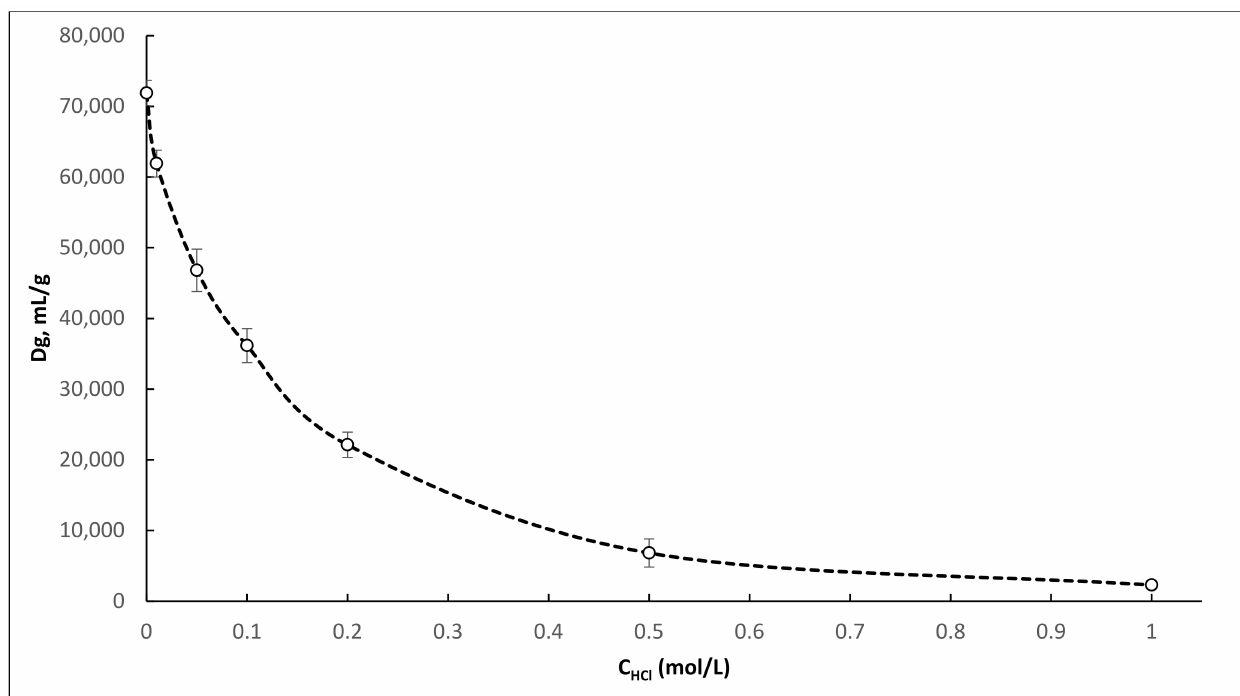
Table 2. Dependence of 44 Sc yield on eluent composition (mean ± SD, n = 10). Eluent Composition 44 Sc Yield, Elution Volume, mL %Oxalic Acid, mol/L HCl, mol/L 0.05 90 ± 3 0.1 91 ± 3 0.1 5 0.2 93 ± 4 0.025 0.125 21 ± 4 0.005 0.007 13 ±